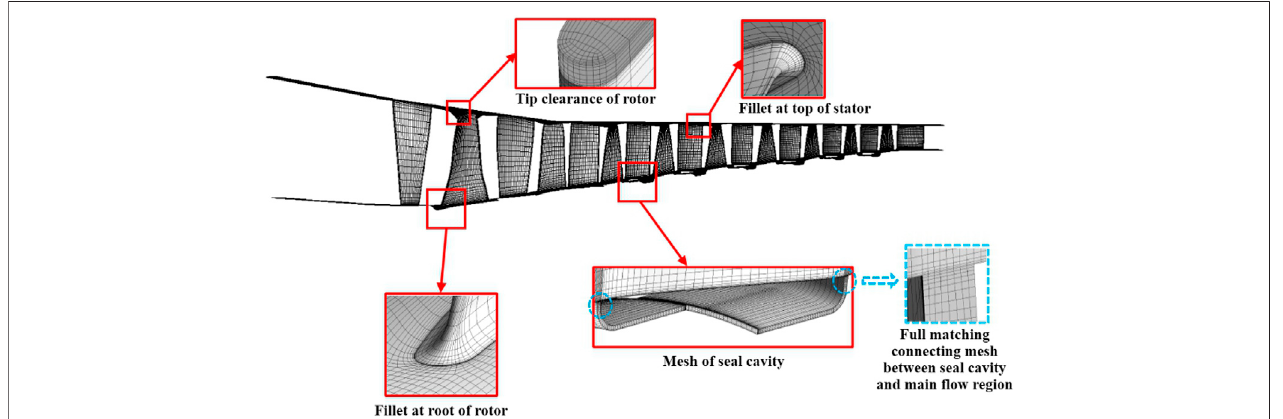
FIGURE 3 | Computational mesh generation of the nine-stage axial compressor.